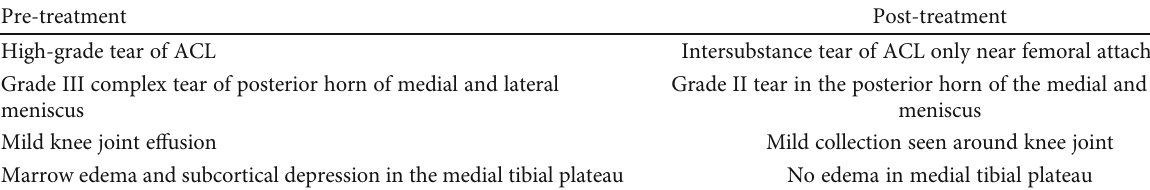
Table 3: Pre- and post-treatment MRI fi ndings of the patient.